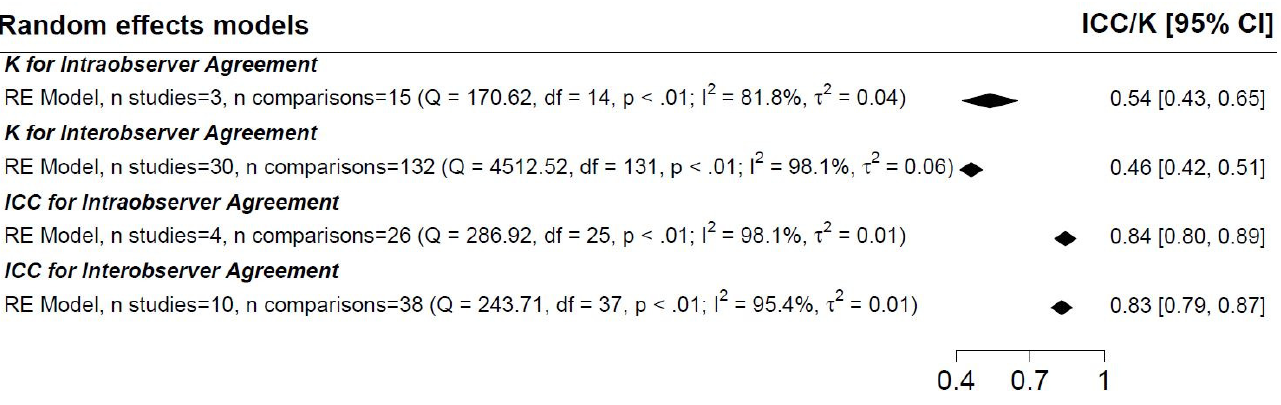
Figure 4. Pooled random effects model for inter/intra-observer agreement by studies reporting Kappa statistics or inter/intra-class correlation coefficient.